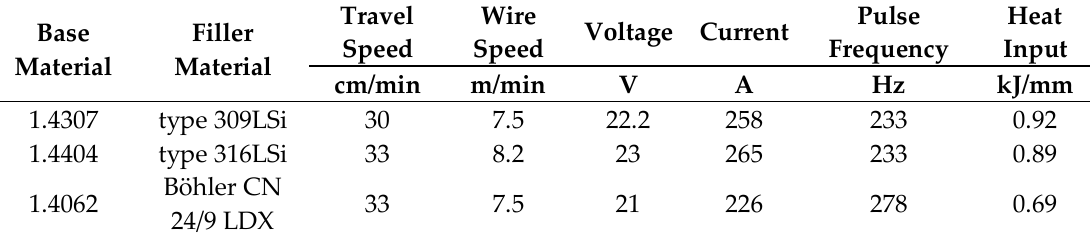
Table 1. Overview of the welding parameters and the resulting heat input.